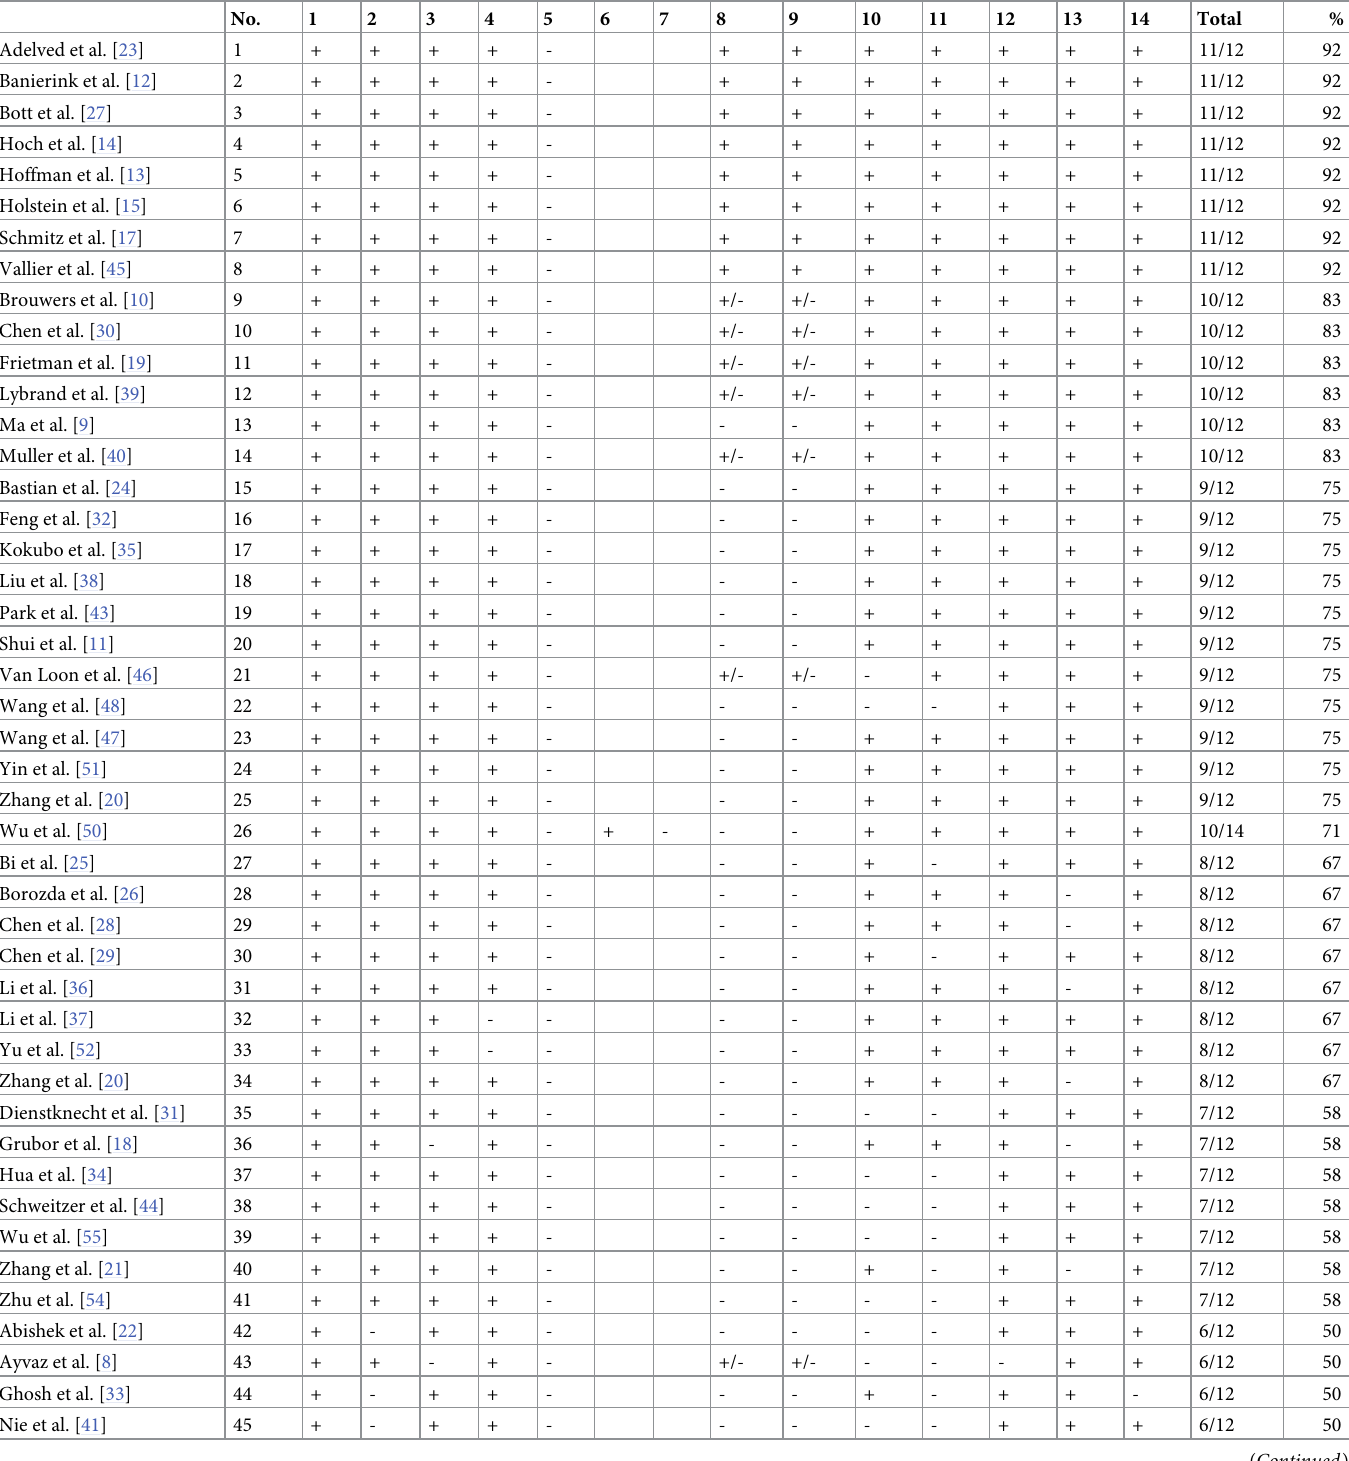
Table 3. Scores of the quality assessment list ranged from best to worst score.